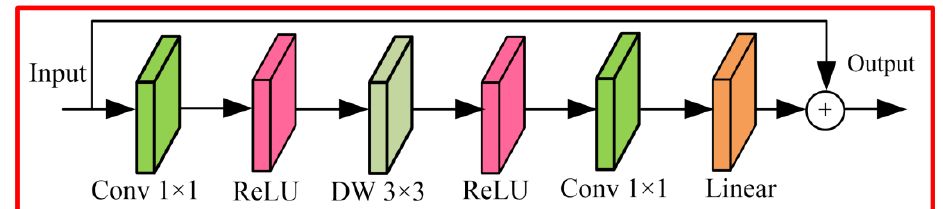
Figure 2. Structure of MobileNet.